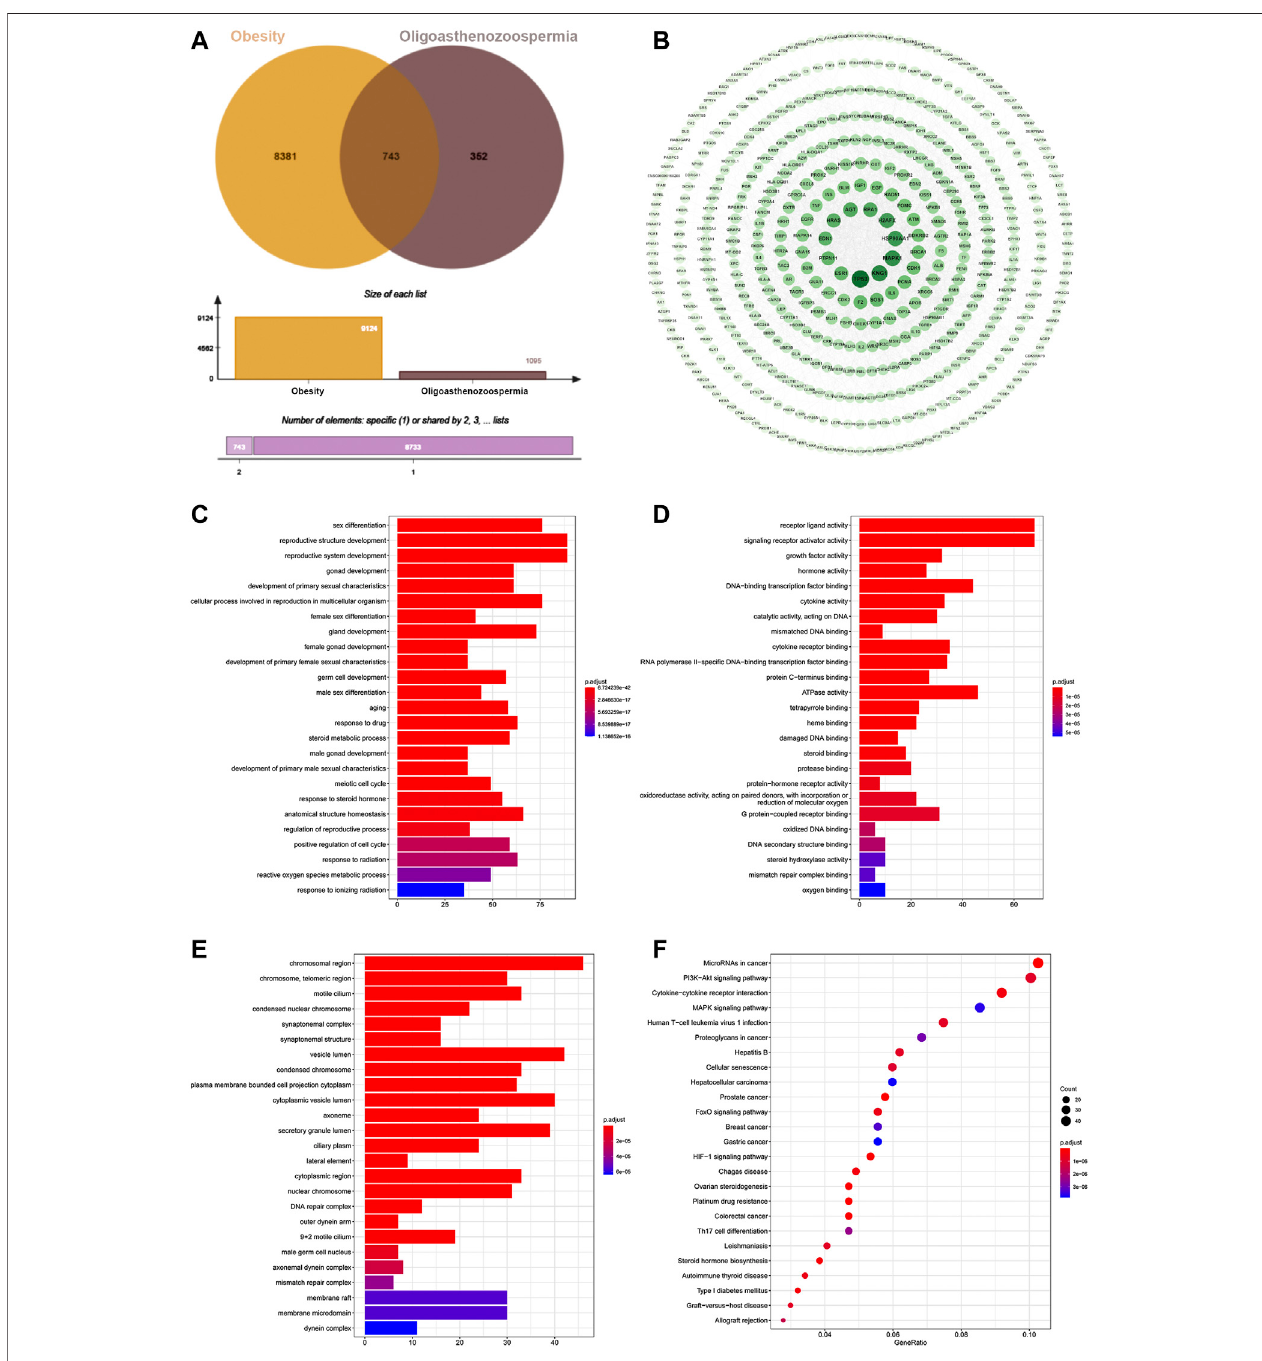
FIGURE 3 | (A) Venn diagram of 743 target intersections for O-O. (B) The PPI network of O-O. The darker node color and larger font size represent larger degree values. (C) BP of the top 25 enriched GO terms and pathways. (D) MF of the top 25 enriched GO terms and KEGG pathways. (E) CC enrichment results of the top 25 enriched GO terms and KEGG pathways. (F) KEGG pathway of the top 25 and its corresponding